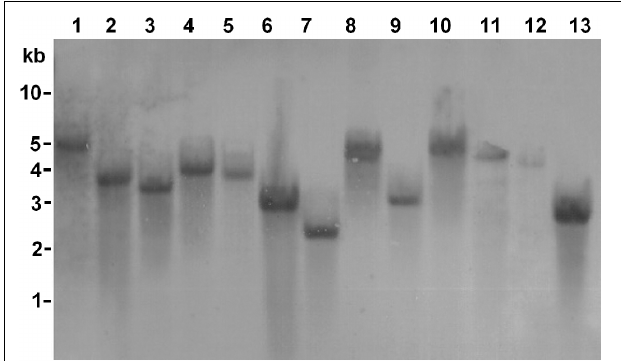
FIGURE 4 | Southern blot of Himar1 transposon insertions. Genomic DNAs were extracted from 13 random transconjugants. DNA was digested with Eco RI and Bam HI. Digoxigenin-labeled DNA containing the insertion sequence was used as a probe. The sizes of DNA markers are shown on the left in kilobases. Lanes 1–13 consisted of digested DNA from random transconjugants.